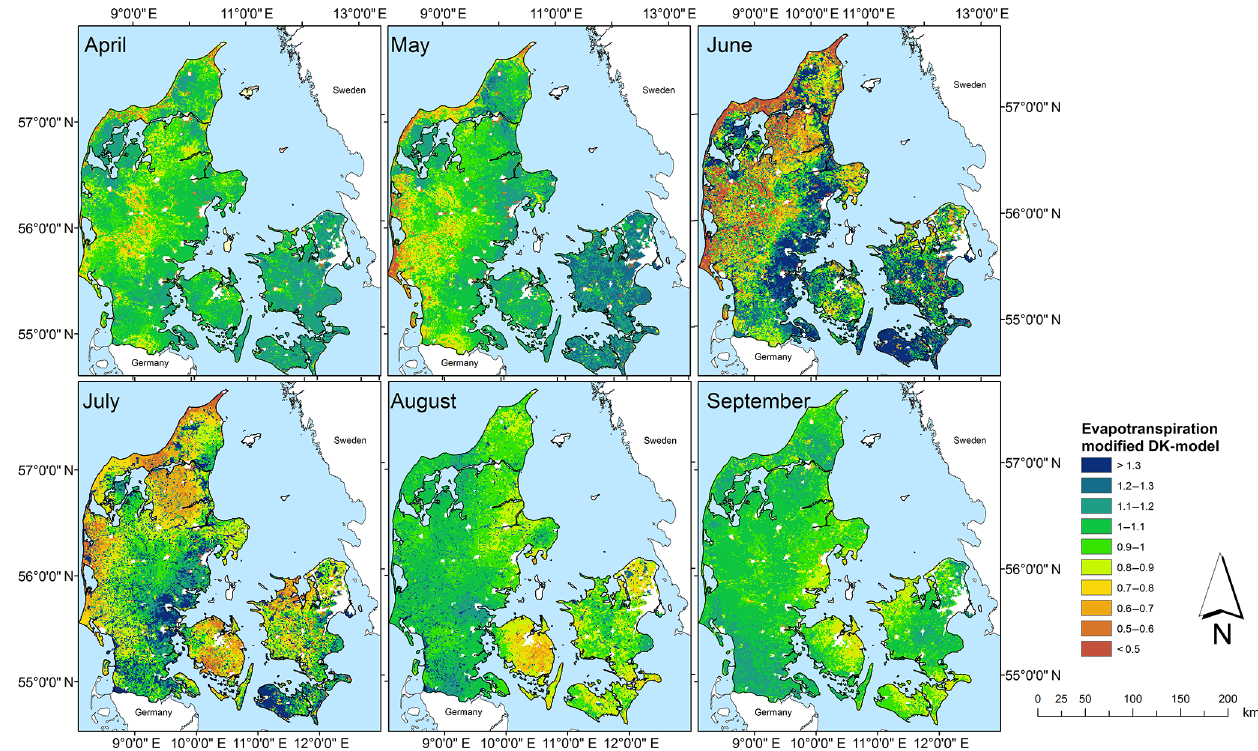
Figure 7. Monthly mean normalized modified DK-model ET maps (–) in which urban areas have been masked out.